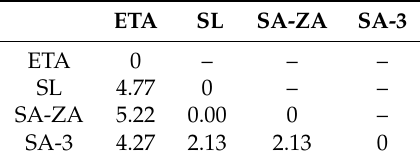
Figure 7. Sensitivity of PAA reductions. Case of SL’s DMA. ( a ) SL DMA—Original water demand values and PAA computed through 50 segments; ( b ) SL DMA—Original water demand values and PAA computed through 100 segments; ( c ) SL DMA—Original water demand values and PAA computed through 200 segments; ( d ) SL DMA—Original water demand values and PAA computed through 400 segments. Table 2. MINDIST for the 4 DMAs of the